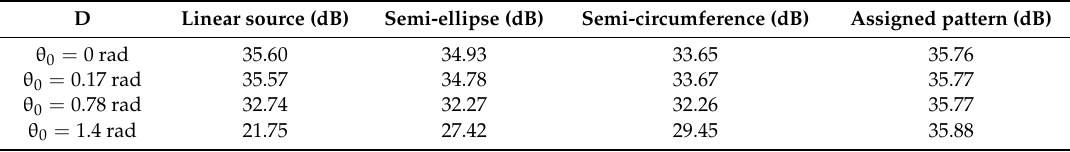
sources, varying the main beam angle θ 0